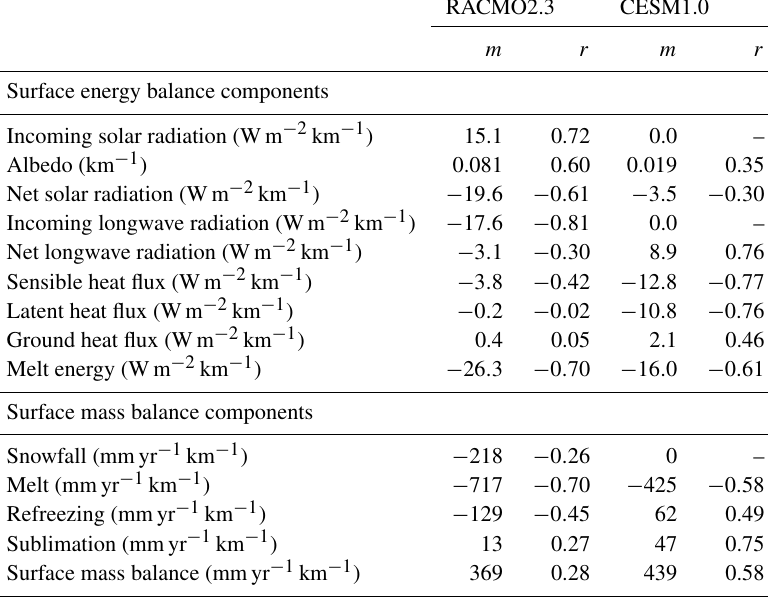
Table 1. Gradients ( m ) and correlation with elevation ( r ; unitless) of surface energy and mass balance components as simulated through EC downscaling in CESM1.0. Values correspond to JJA (energy) and annual (mass) averages for the period 1965–2005. Melt energy is the sum of the net shortwave and longwave radiation and the heat fluxes. Surface mass balance is the sum of snowfall and refreezing, minus melt and